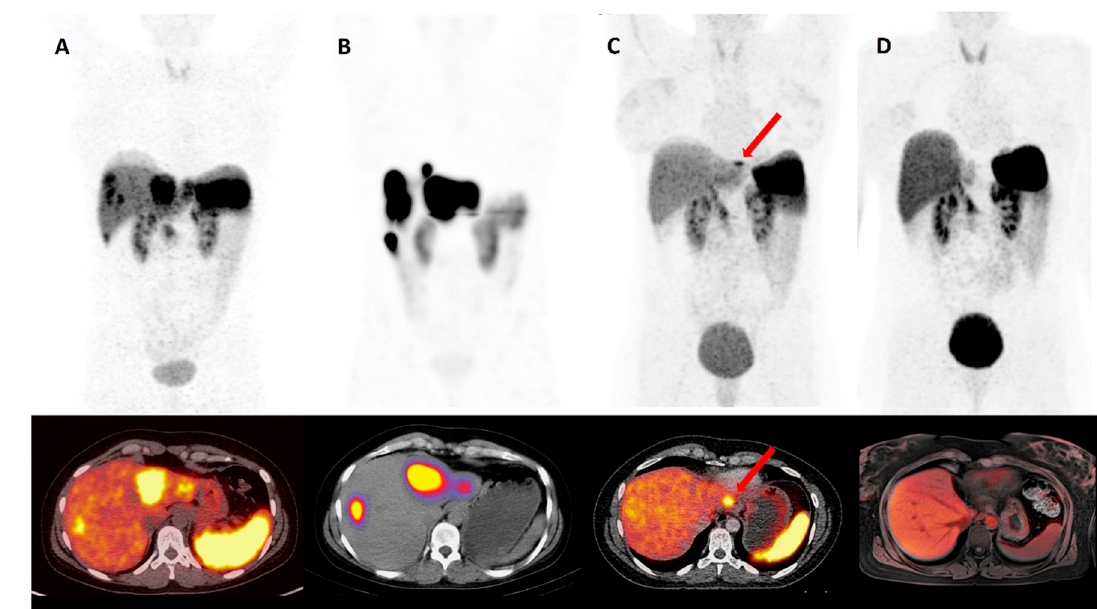
Figure 1. A 38-year-old woman with NET of the rectum G3 (Ki-67 in hotspots up to 25%) with hepatic and locoregional lymph node metastases. Pretherapeutic ( A ) and post-therapeutic ( C ) 68 Ga-DOTATAOC-PET / CT. After interdisciplinary tumor board decision, 1st cycle PRRT with 7.4 GBq 177 Lu-DOTATOC ( B ). After three cycles of PRRT, only one remaining hepatic lesion in segment II ( C , red arrow head) is left. Following a curative approach, the patient underwent a laparoscopic left-lateral liver resection. The patient is currently undergoing semi-annual screening at complete response (CR) 68 Ga-DOTATAOC-PET / MR ( D ).